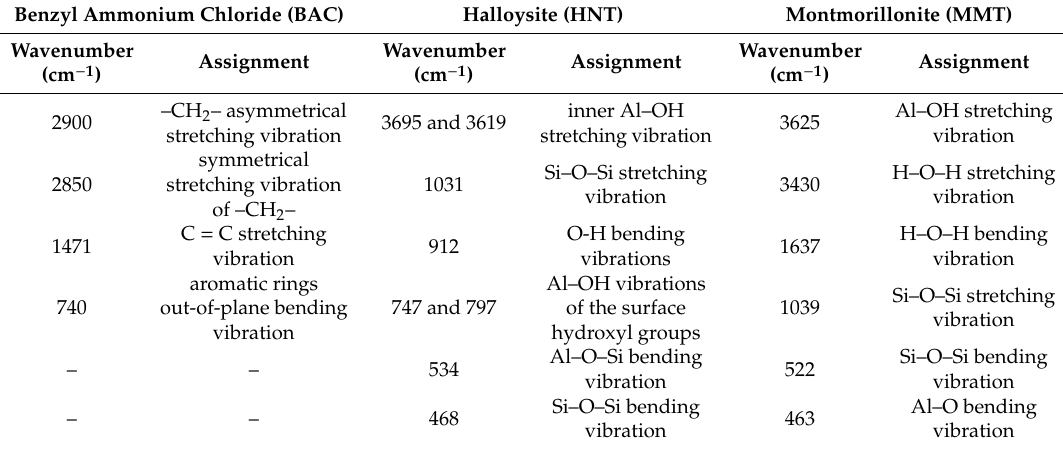
Table 1. Wavenumbers and assignments of the FT-IR vibration bands.